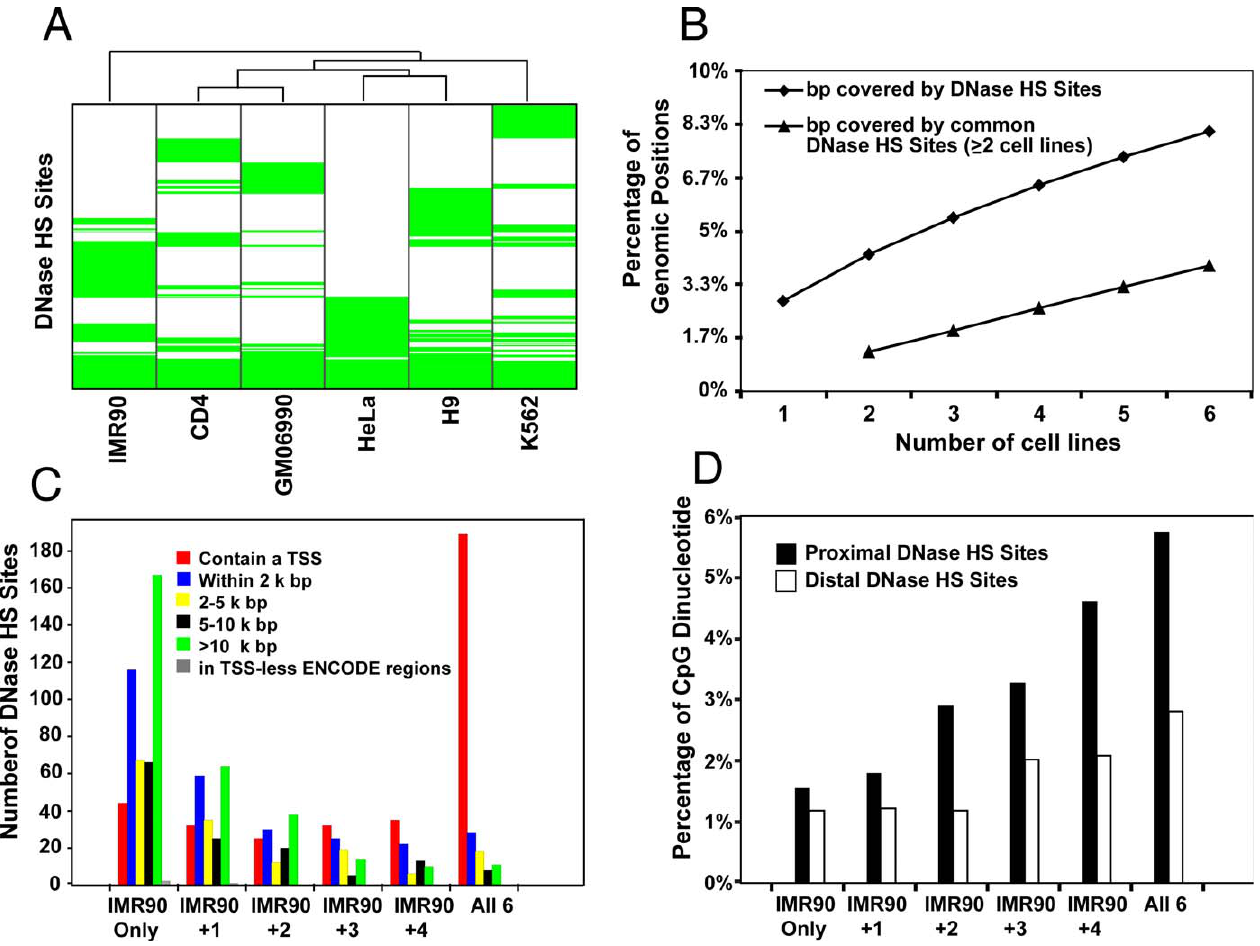
Figure 2. Identification and Characterization of DNaseI HS Sites (A) Clustering of six cell lines based on DNaseI HS site profiles. ENCODE regions were divided into 2-kb blocks and a binary DNaseI HS site profile was calculated for each cell line (1 for blocks containing a DNaseI HS sites hit, displayed in green, and 0 otherwise, uncolored). Cell lines were clustered based on their DNaseI HS sites hit profiles using Wards hierarchical clustering [41] with Euclidian distance as the metric. Ubiquitous DNase sites are grouped at the bottom. (B) Cumulative percentage of the genome covered by DNaseI HS sites from increasing number of cell lines. Diamonds represent cumulative percentage of the genome covered by DNaseI HS sites from any cell line. Triangles represent cumulative percentage of the genome overlapped by DNaseI HS sites shared by at least two cell types. Each point is an averaged value of all possible cell line combinations. (C) Location of DNaseI HS sites relative to TSS. DNaseI HS sites from IMR90 cells were first categorized as unique to IMR90, common with other cell types, or ubiquitous in all six cell types. Data centering on other cell types are identical (unpublished data). Distances of each DNaseI HS site were calculated to the nearest TSS. (D) CpG dinucleotide distribution. The percentage of CG dinucleotide was determined for proximal and distal DNaseI HS sites that were unique to IMR90, common with additional cell types, or ubiquitous within all six cell